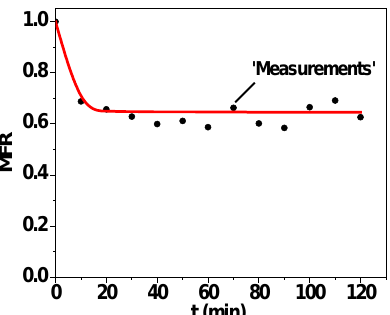
Figure 6. Isothermal dilution measurements (MFR as function of time) for an aerosol with 60% 0.01 μg m -3 , 40% 10 μg m -3 , ΔH vap =100 kJ mol -1 and a m =1. The red line corresponds to the true properties of the aerosol and the black dots are the ‘measured’ MFR values.